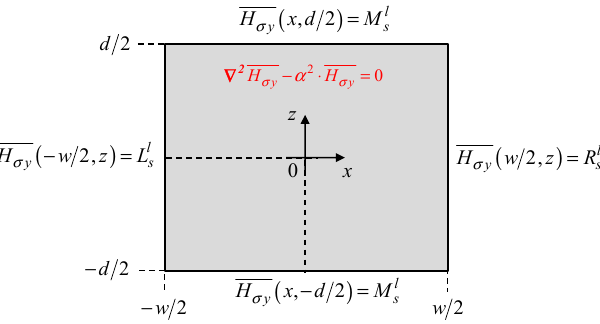
Figure 11. Boundary conditions (BCs) at edges of massive conductive parts in a ( x , z ) coordinate system and ∀ l .